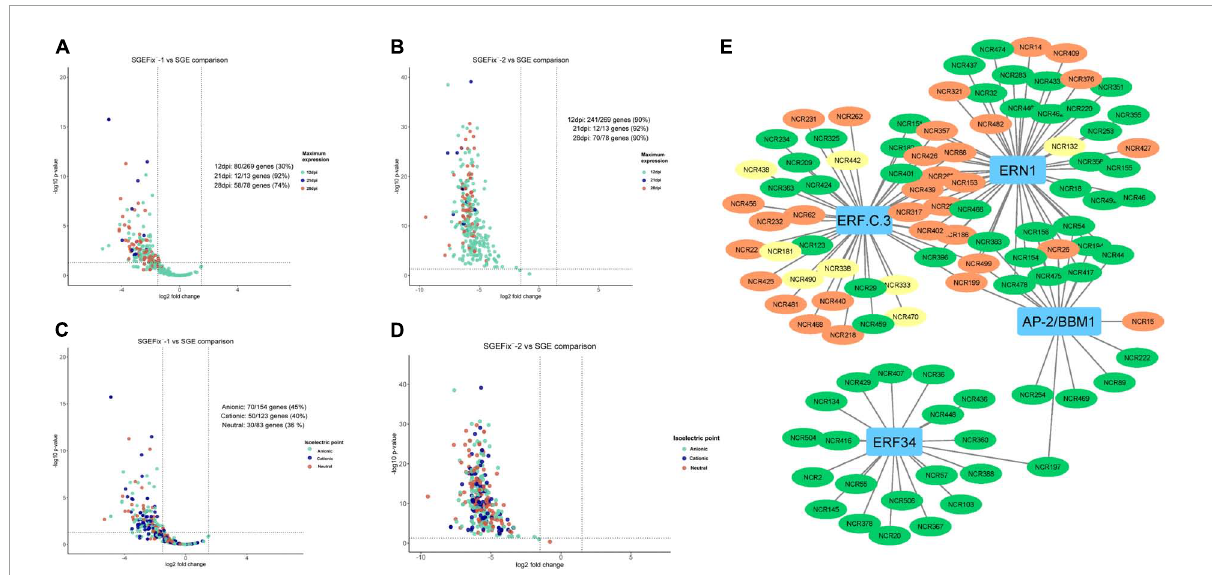
FIGURE9 (A) Volcano plot showing the distribution of “early” and “late” NCRs among differentially expressed NCR genes in mutant SGEFix − -1 ( sym40-1 ). (B) Volcano plot showing the distribution of “early” and “late” NCRs among differentially expressed NCR genes in mutant SGEFix − -2 ( sym33-3 ). (C) Volcano plot showing the distribution of cationic/anionic/neutral NCR peptides among differentially expressed NCR genes in mutant SGEFix − -1 ( sym40-1 ). (D) Volcano plot showing the distribution of cationic/anionic/neutral NCR peptides among differentially expressed NCR genes in mutant SGEFix − -2 ( sym33-3 ). (E) NCR gene regulatory network based on gene expression data of wild-type and mutants SGEFix − -1 and SGEFix − -2. NCR genes with a maximum expression at 12 dpi are colored green. NCR genes with a maximum expression at 21 dpi are colored yellow. NCR genes with a maximum expression at 28 and 42 dpi are colored